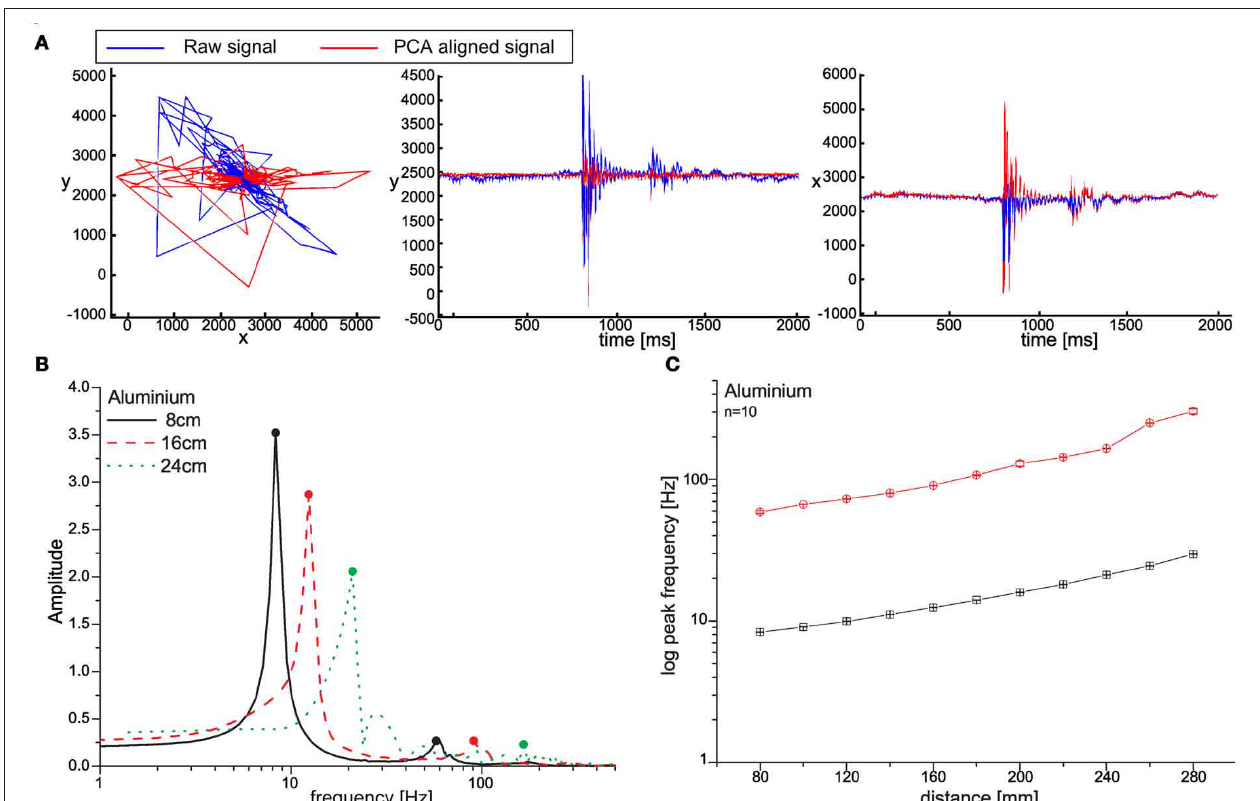
distance wasencoded byoscillation frequencies. (B) FFT amplitude spectra of three single contacts withanaluminiumrod,taken at8,16,and24cmdistance. As contact distance increased, the low-frequency peak decreased in amplitude and shifted to higher frequencies. Multiple high-frequency modes could occur, but only the largest mode beyond 55Hz wasanalysed further. (C) Peak frequencies of both frequency ranges increased exponentially with distance ( n = 10, means ± SD, note that error bars are within symbols); red: high frequency component; black: low frequency